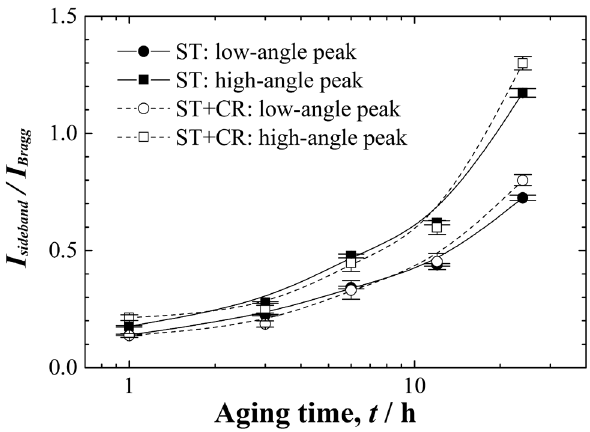
Fig. 6: Variations in the integrated intensities of sideband peaks for the 220 reflection normalized by a Bragg